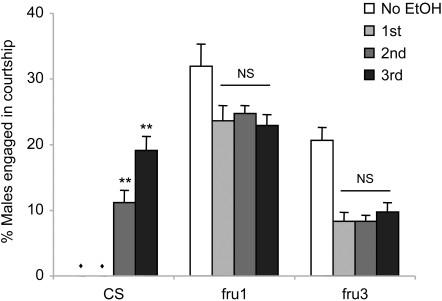
Effects of chronic ethanol on courtship behavior of fru males.
fru1 and fru3 males showed vigorous intermale courtship in Flypub without ethanol (No EtOH). Upon daily ethanol treatments in 95% Flypub, their courtship activities did not change with additional ethanol treatment while the courtship levels under ethanol were lower than those without ethanol (ANOVA: fru1, F3,27 = 3.24, p = 0.0396, Tukey-Kramer showed a significant difference between No EtOH and 3rd EtOH; fru3, F3,27 = 16.94, p<0.0001, No EtOH was significantly different from the others by Tukey-Kramer; n = 7). NS, not significant. CS males tested together with fru males as a control showed negligible intermale courtship in the absence of ethanol and on the 1st ethanol exposure (marked by diamonds); however, their courtship activities were enhanced under the influence of ethanol on the 2nd and 3rd ethanol treatments (F3,27 = 42.86, p<0.0001; double asterisks, significant difference by Tukey-Kramer).